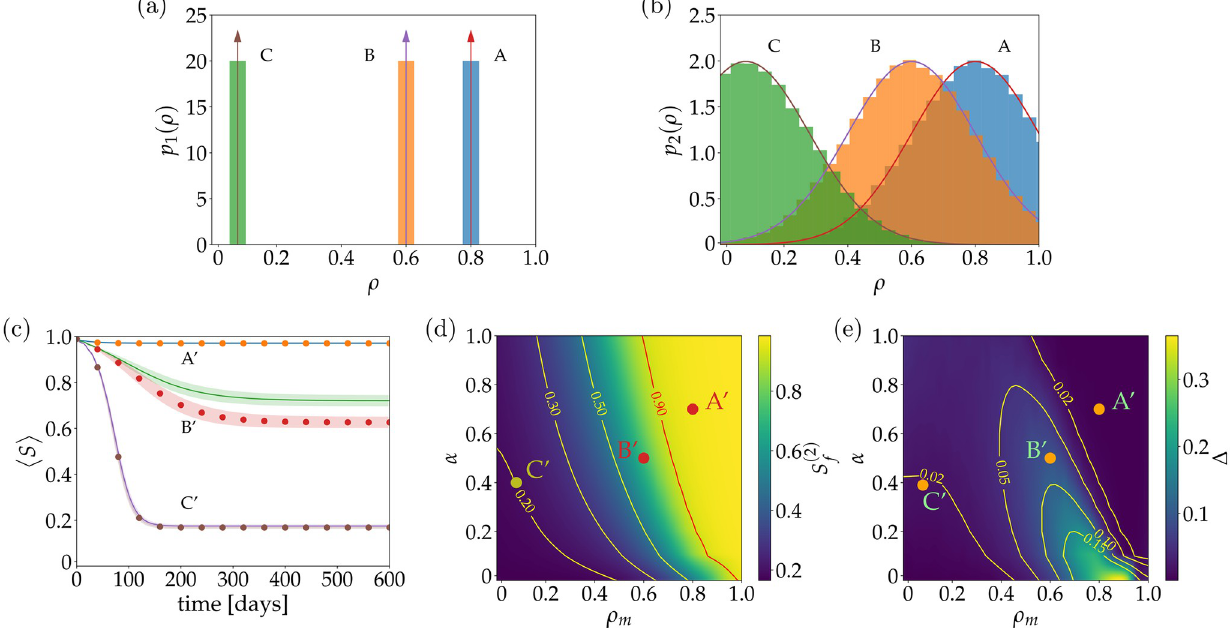
Fig 2. Accessing homogeneity and heterogeneity effects on the ABM simulation. Different probability distributions of the awareness decay constant ρ were used to evaluate the effect of heterogeneity by considering a sampling process from a (a) Dirac delta and (b) a truncated Gaussian distribution. In both plots, bars are the sampled distribution and solid lines are the analytic curves, where the arrows in (a) indicate the delta function. (c) Evolution along time of susceptible agents for different values of the mode of decay constant ρ m vs the ratio of informed agents α . Continuous lines represent simulations where ρ m is sampled from a Gaussian distribution and dotted lines, the sampling from a Dirac delta distribution. Shaded areas represent the standard deviation obtained from 100 independent simulations. (d) Density plot of the final ratio of susceptible agents at the end of an epidemic when there is a heterogeneous distribution of ρ , for different values of ρ m and α . Contours lines show the boundary for high and low impact epidemic. (e) Density plot of the difference of final susceptible agents between homogeneous and heterogeneous systems for different ρ and α . Contour lines delimit areas of low and high difference m between systems. In panel (a) and (b), points A, B and C represent different values of ρ m , 0.8, 0.6 and 0.1, respectively. In figures (c), (d) and (e) those points represent the pair ( ρ , α ), being A 0 = (0.8, 0.7), B 0 = (0.6, 0.5) and C 0 = (0.1, 0.4). Points are set in interest regions, high (A 0 ), middle (B 0 ) and low (C 0 ) impact m of the information on the epidemic